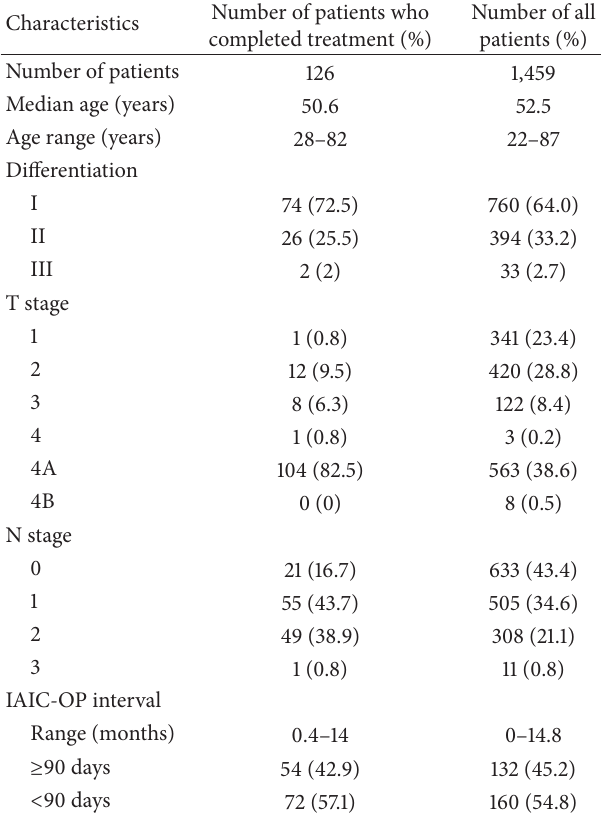
Table 1: Patients’